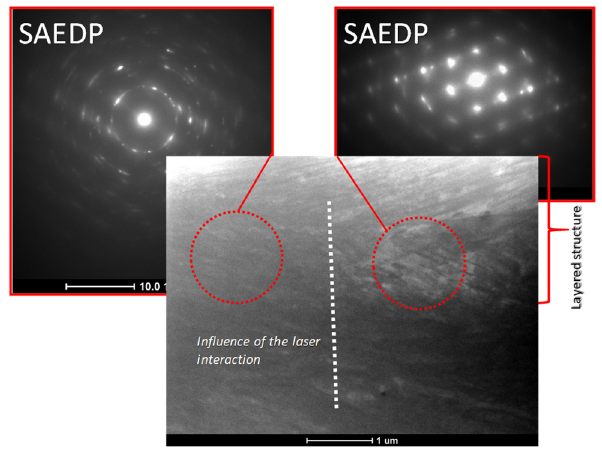
Figure 5. Microstructure TEM analysis of the substrate–layer interaction.